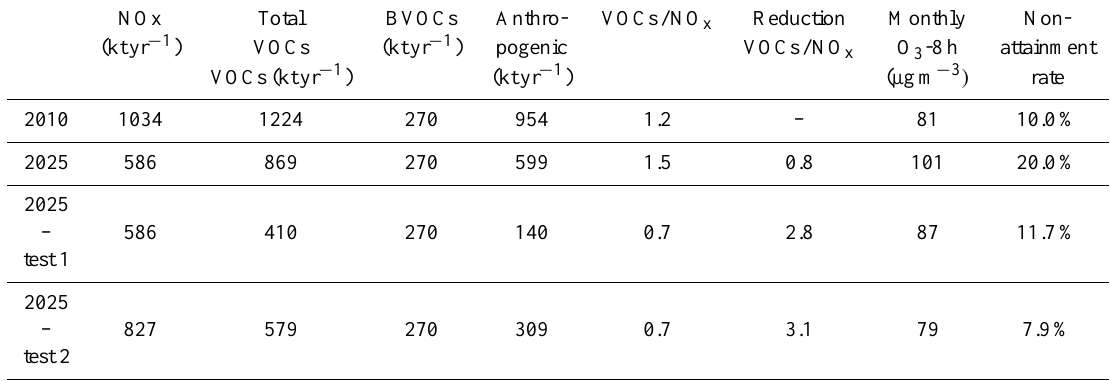
Table 4. Comparison of VOC and NO x emission in PRD and its effect on O 3 during July in Guangzhou between different schemes. NOx Total BVOCs Anthro- VOCs/NO x (ktyr − 1 )